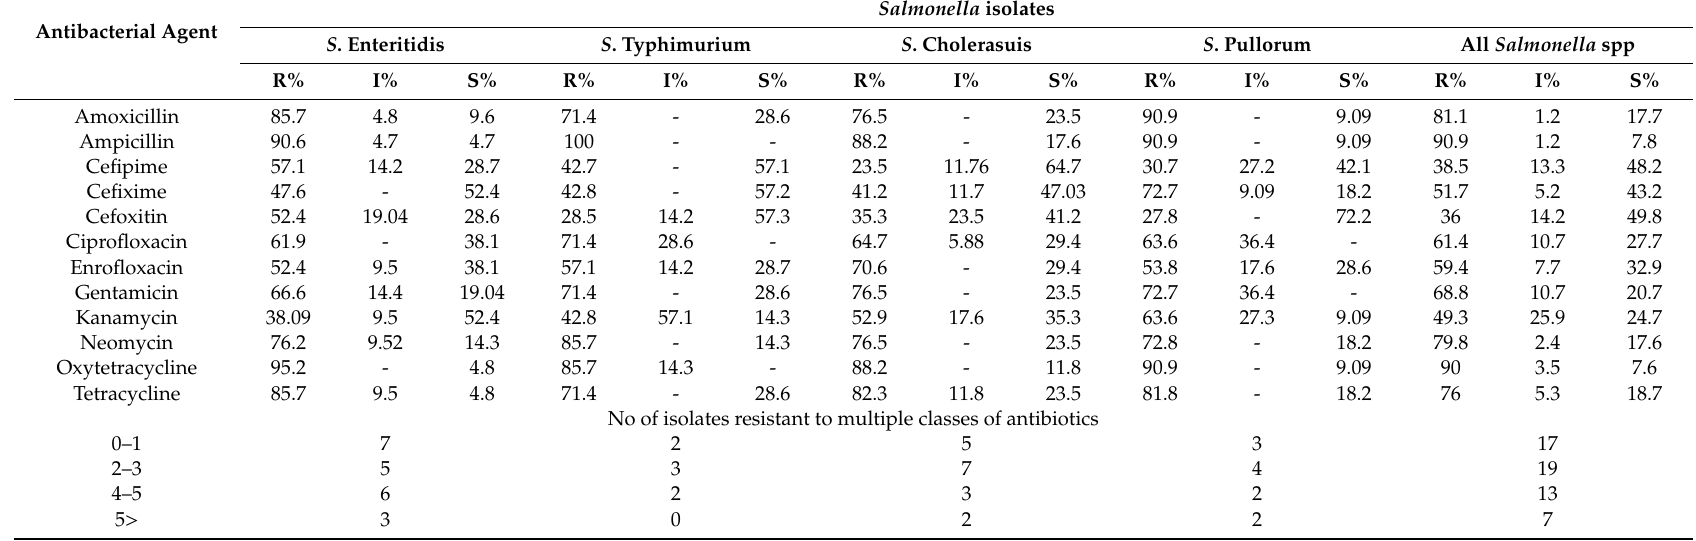
Table 3. Antimicrobial resistance profile of Salmonella